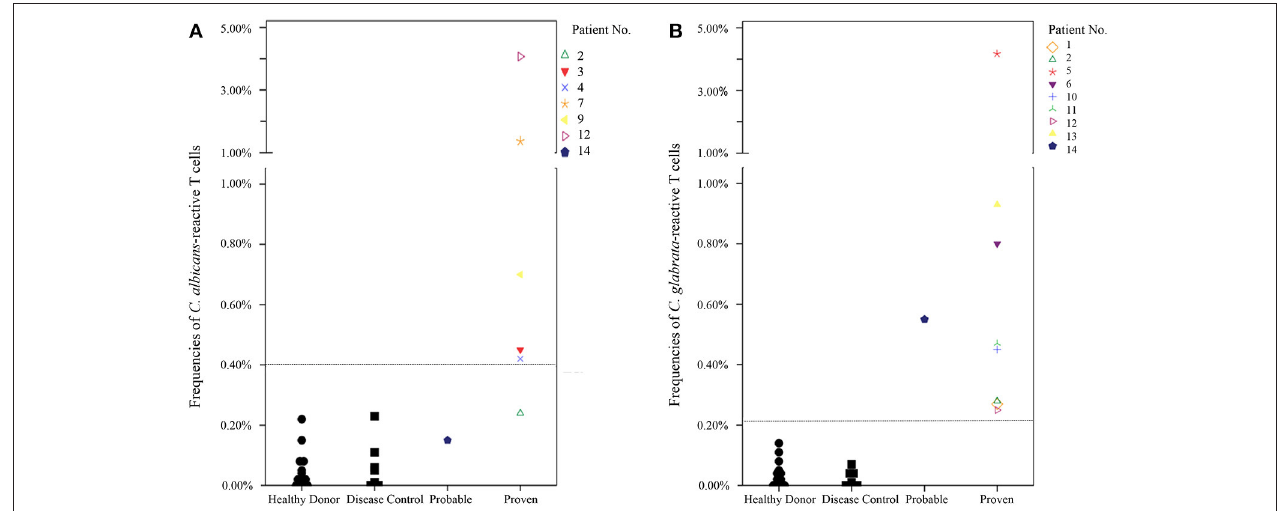
FIGURE 4 | Frequencies of Candida -reactive T cells in healthy donors, disease control and patients with probable or proven invasive Candida infection. Patients with proven invasive Candida infection had a simultaneous 3.05-fold increase of antigen-stimulated T cells compared to unstimulated T cells to exclude false positive results and to determine quality of the stimulation. Dashed lines show cut-off values for C. albicans -reactive T cells (0.40%) and C. glabrata -reactive T cells (0.22%), respectively. Healthy donor n = 14, disease control n = 9. (A) Frequencies of C. albicans CD69 + /CD154 + T cells among CD4 + T cells in donor/patient cohorts. Given is the highest frequency during the test series. (B) Frequencies of C. glabrata CD69 + /CD154 + T cells among CD4 + T cells in donor/patient cohorts. Given is the highest frequency during the test